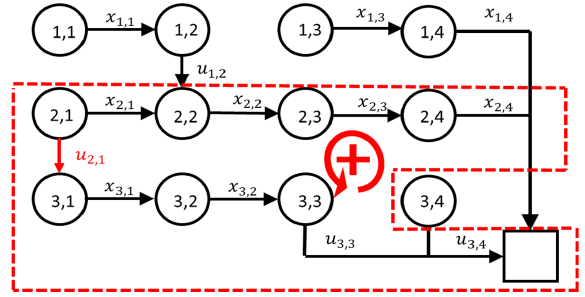
Figure 5. Cycle formed by addition of the arc u 2,1